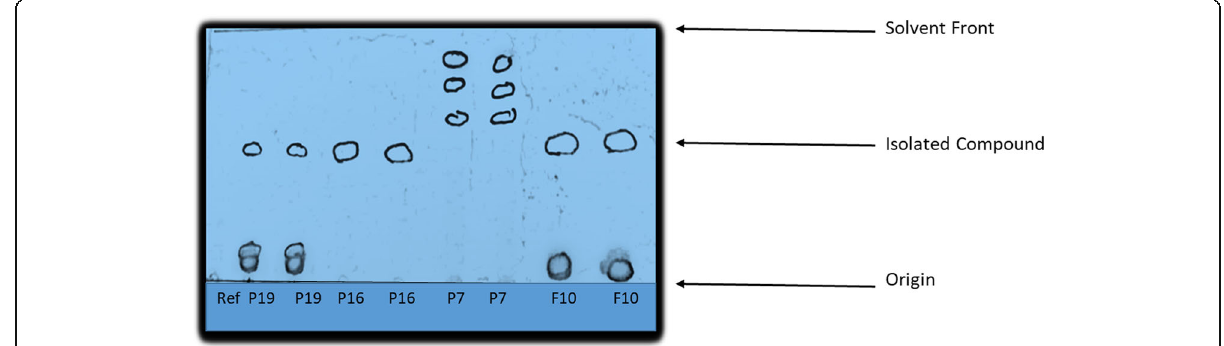
Fig. 2 TLC profile of compounds from column chromatography. Single spot represents a pure compound while more than one spot represents a mixture of compounds isolated from V. adoensis